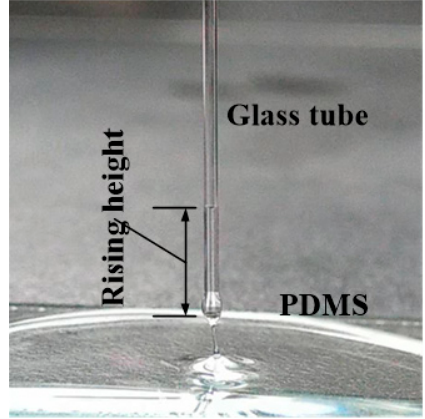
Figure 2. Glass tube with immersed PDMS.